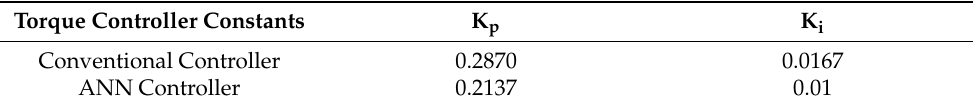
Figure 16. Simulink model of an ANN based direct torque controlled eCAR propulsion system.